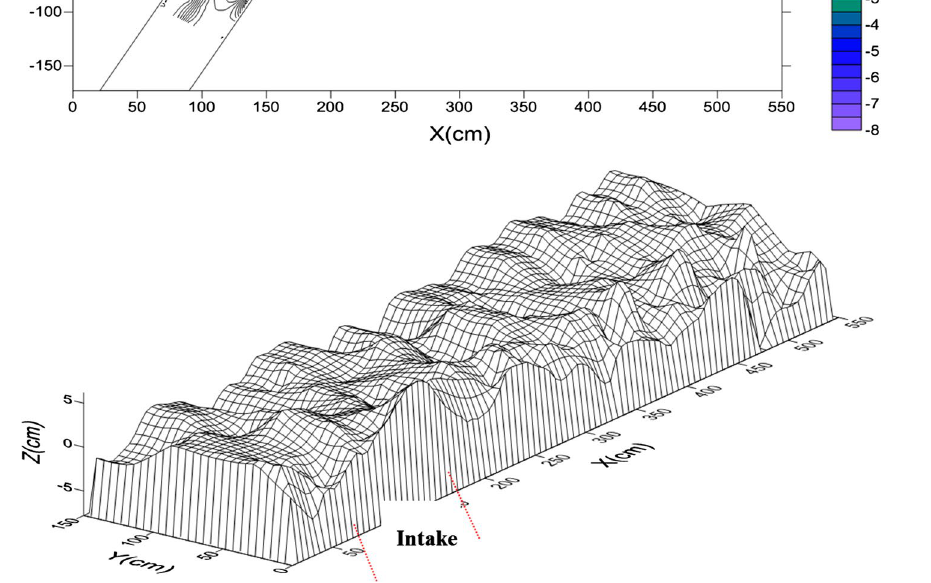
Fig. 7 Bed topography in the main channel with skimming wall ( Q = 0.06 m 3